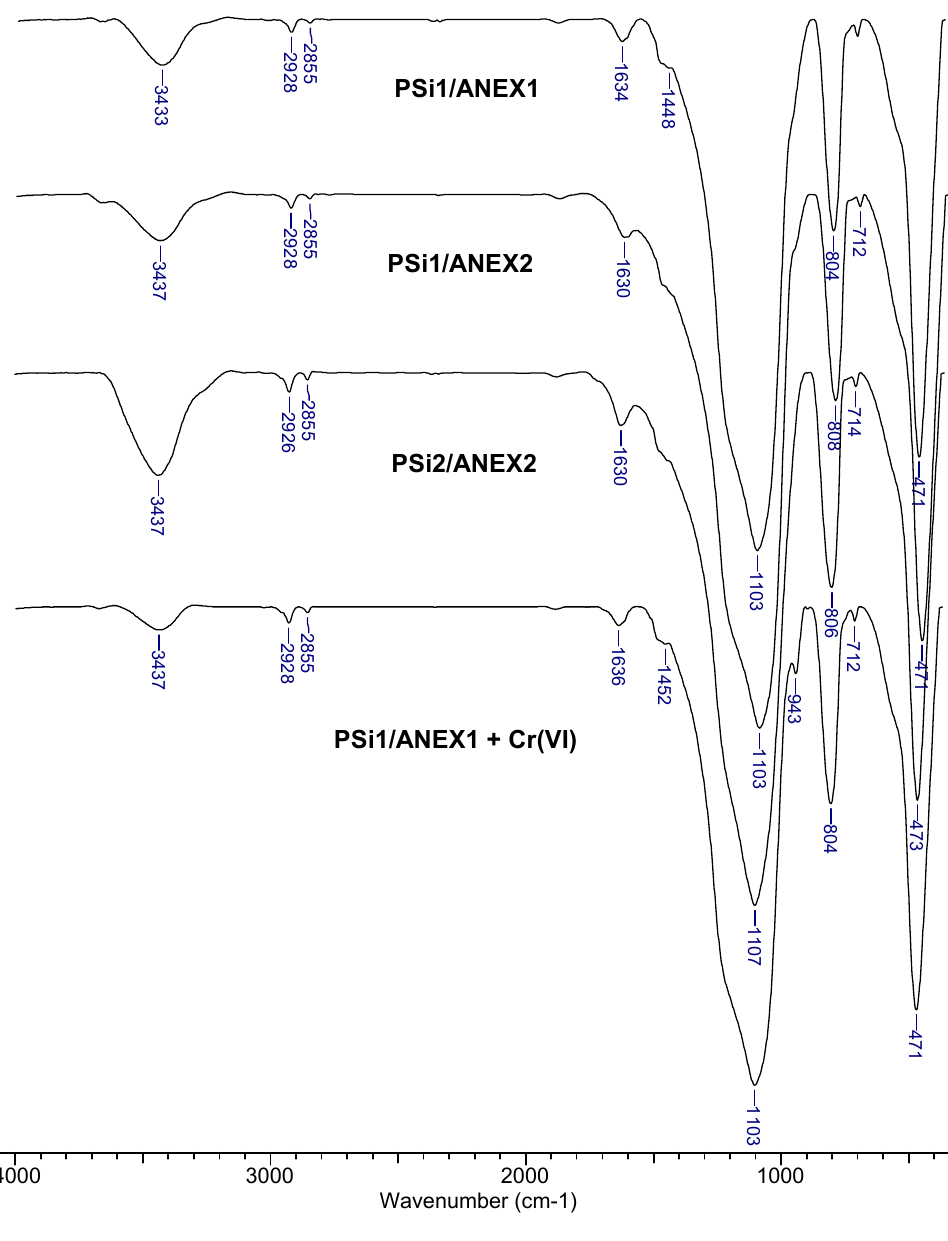
Figure 1. FTIR spectra of the PSi/ANEX composites before loading with Cr(VI) and of the composite PSi1/ANEX1 after loading with Cr(VI).